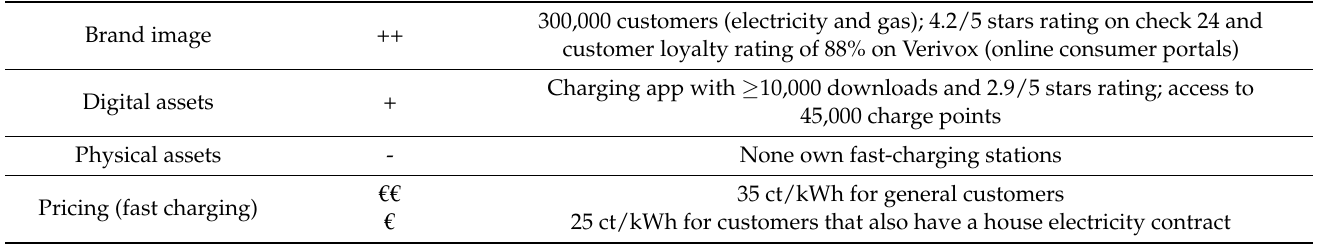
Table 8. Analysis of Maingau [57,58,64–67].